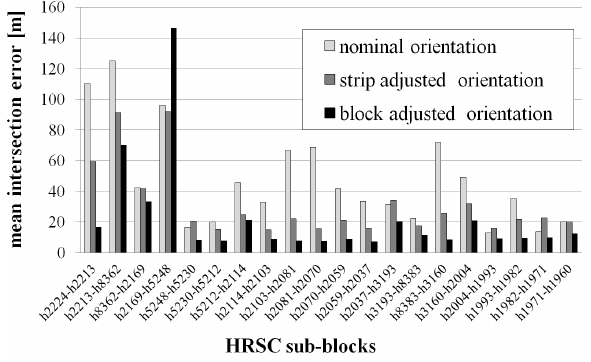
Figure 8: Mean intersection error for overlapping areas in sub- blocks calculated with different orientation values (Dumke et al., 2008). For the depicted example of 21 image strips, the HRSC DTM mosaic is shown in Fig. 10.